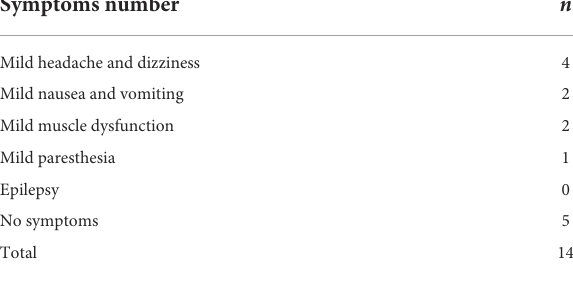
Symptoms number n Mild headache and dizziness